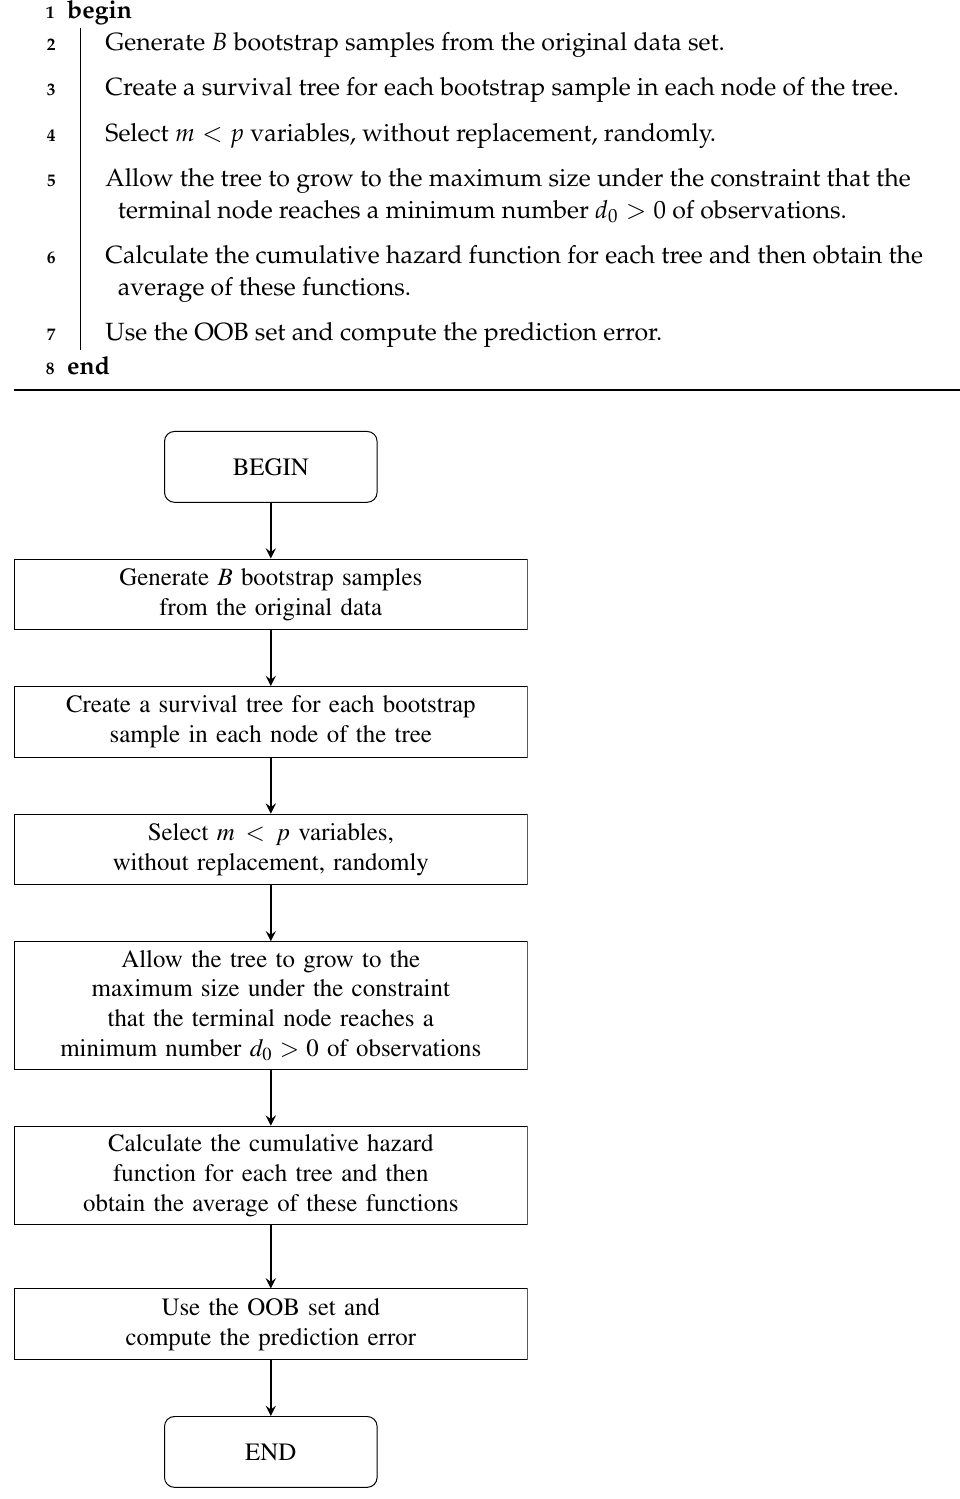
Figure 1. Flow diagram of the random survival forest